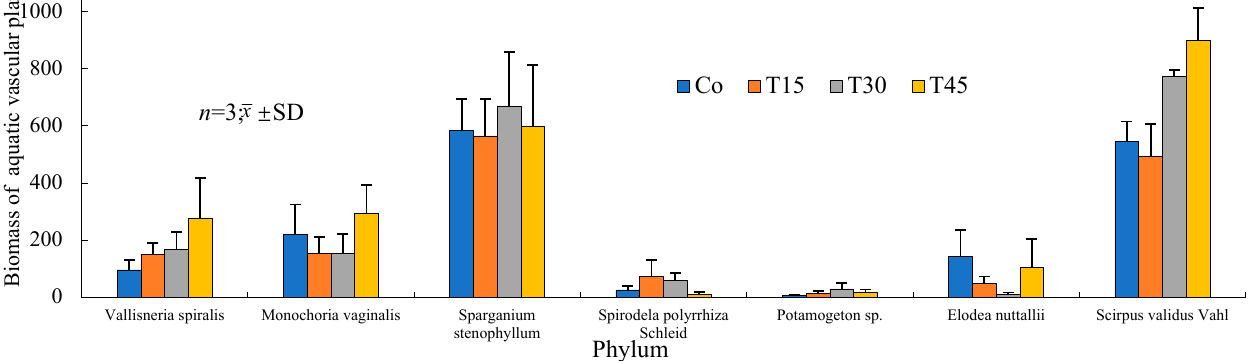
Figure 12. Composition of the predominant zooplankton species in different treatment groups during the experiment.